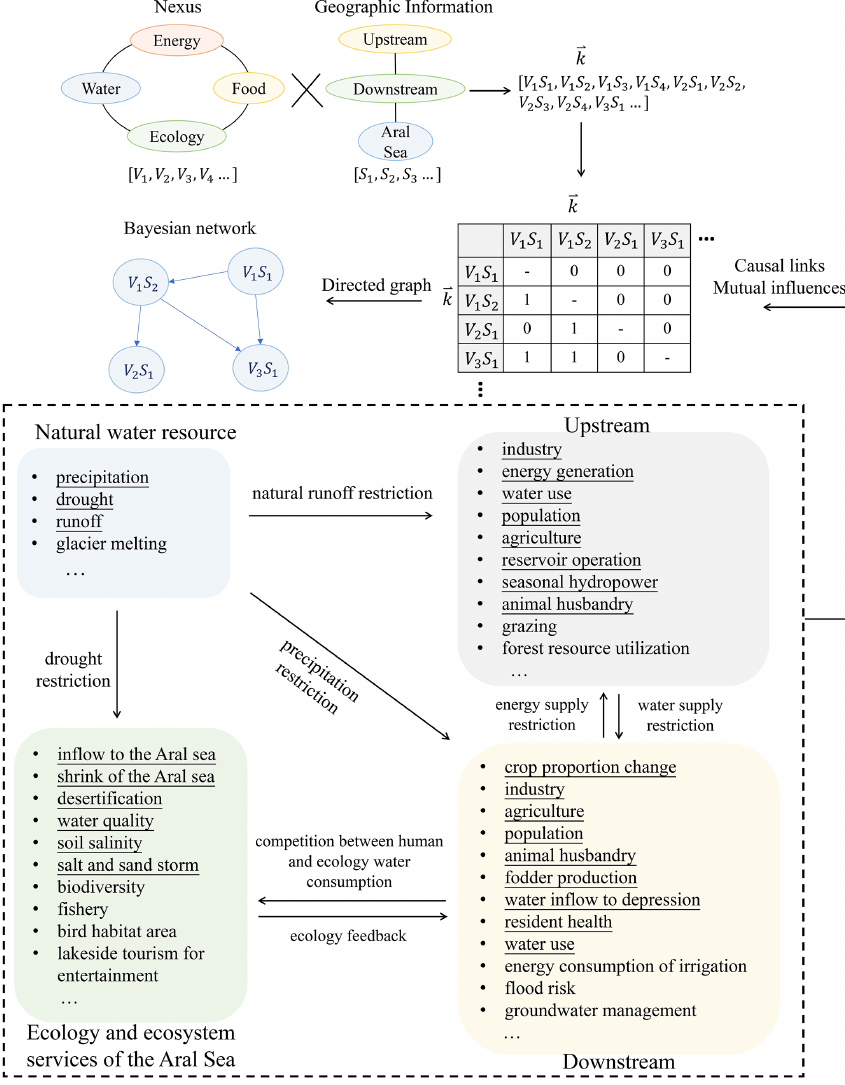
Figure 5. Integrate expert knowledge into Bayesian networks to simulate the WEFE nexus. The geographical area is divided into the upstream and downstream regions and the surrounding area of the Aral Sea. The lower part contains the factors that can be considered in the framework, and the underlined ones are actually used in this